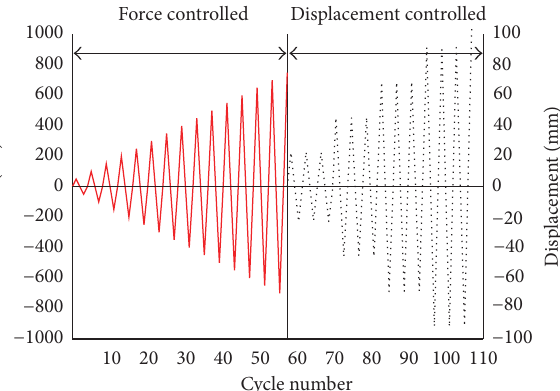
Figure 4: Test setup.